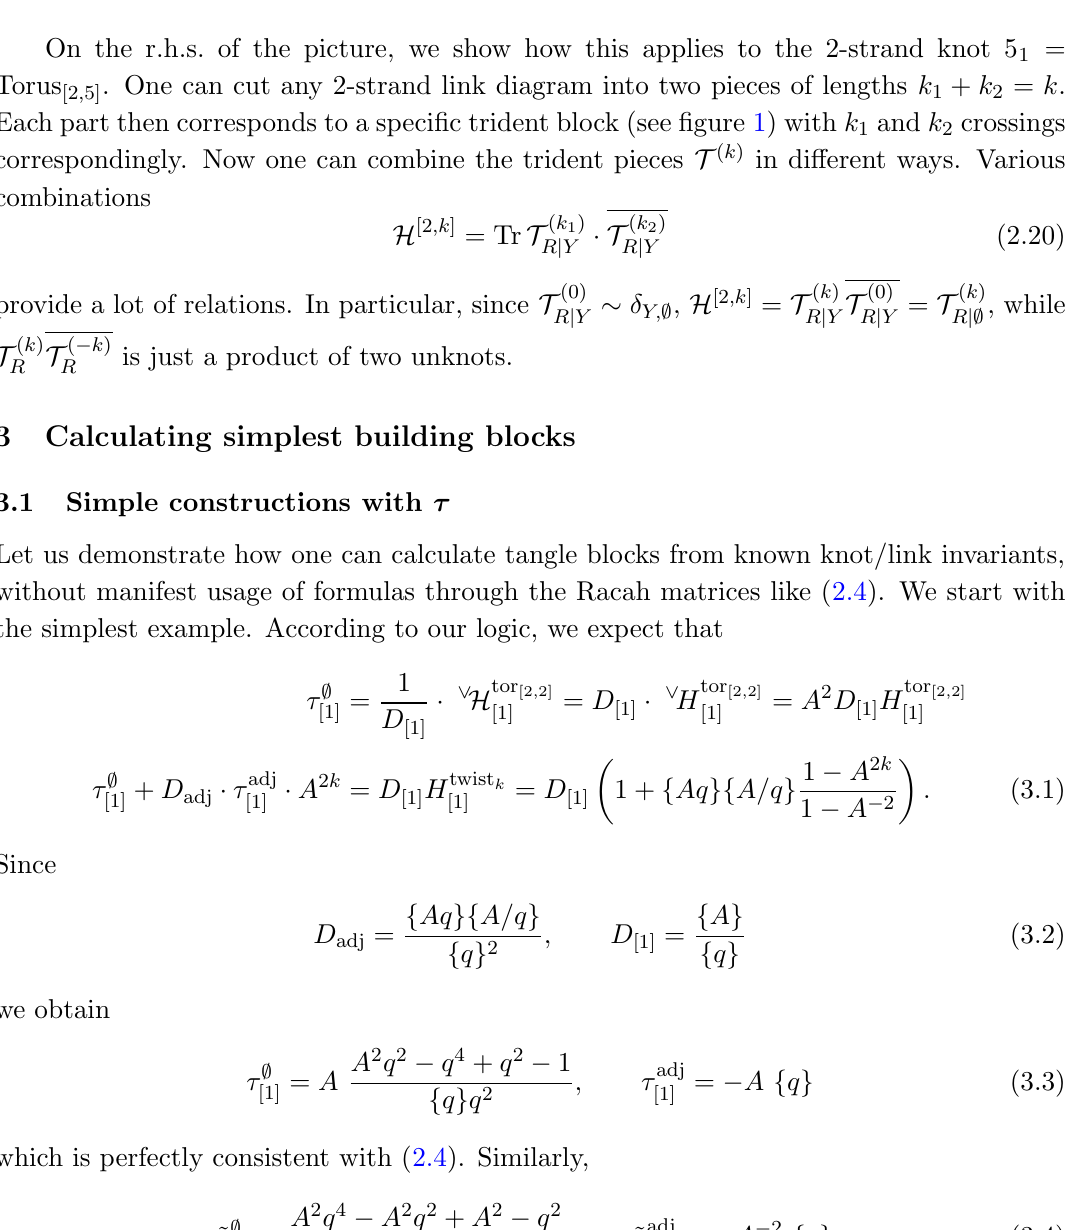
( k ) , where there is just a two strand braid with k crossings. On T (0) (cid:14) Y; ; is T (cid:24)